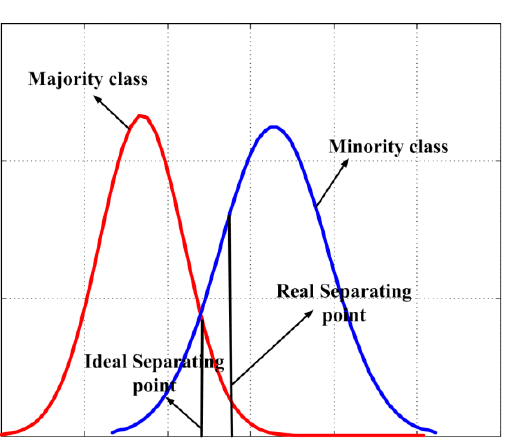
Figure 5. An example that explains why imbalanced data distribution can hurt classification models. els. When P ( Y + | X ) = P ( Y − | X ) , i.e., P ( X | Y + ) P ( Y + ) = P ( X | Y − ) P ( Y − ) , selecting the is